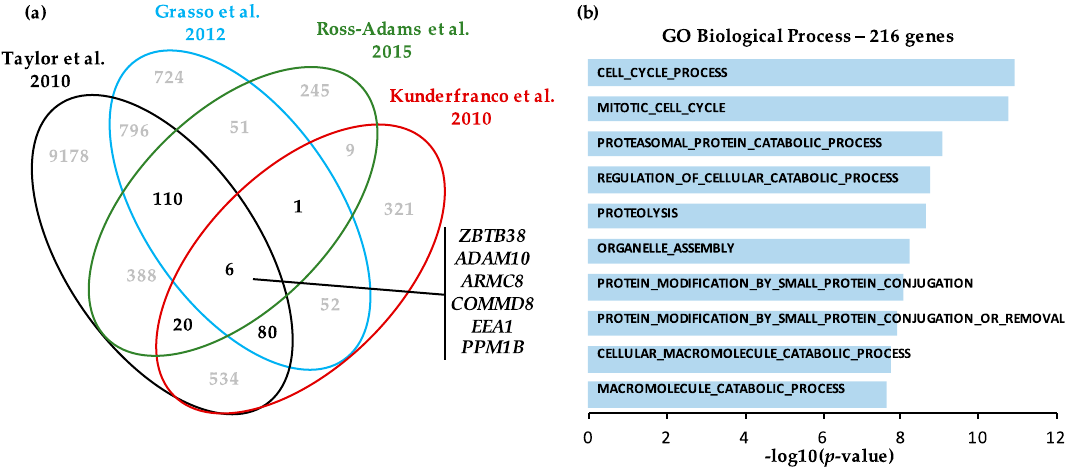
Figure 4. A gene expression analysis unveils a gene signature linked to ZBTB38 expression and doxorubicin-sensitivity in patients with prostate cancer. ( a ) Venn diagram showing the list of genes differentially expressed in 4 cohorts of patients between tumours expressing low (1st quartile) and high (4th quartile) levels of ZBTB38 . ( b ) Biological annotation of the gene expression signature, in “ ZBTB38 -high” versus “ ZBTB38 -low” expressing tumours (by using the online MSigDB tool). 2.8. Knock-Down of ZBTB38 Promotes ROS Accumulation, Cell Migration and Doxorubicin Toxicity in